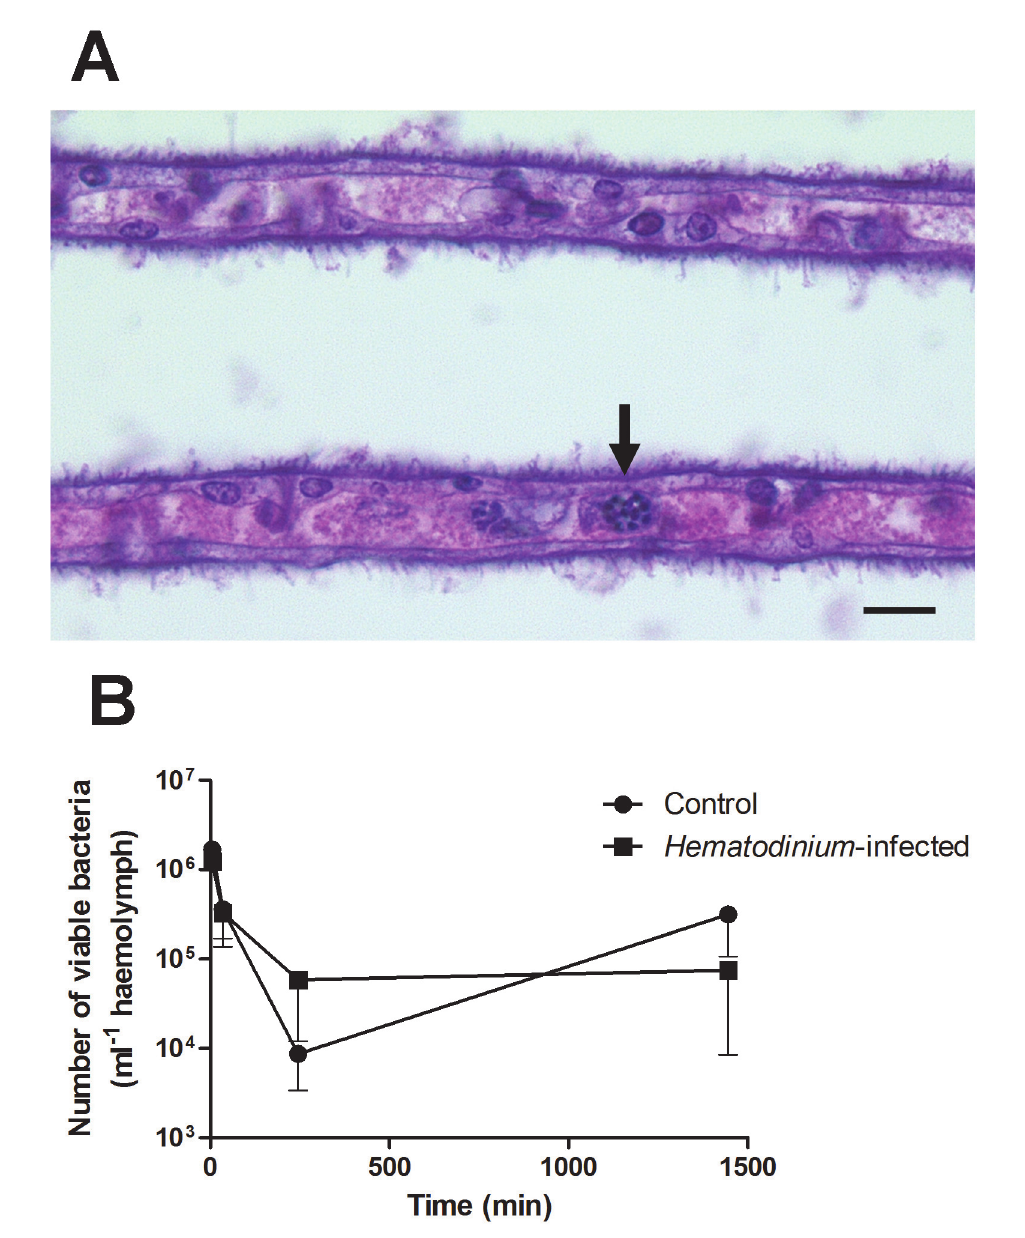
Fig 2. Experimental exploration of the interaction between Hematodinium and its host. (A). Histological appearance of gill lamellae of a crab seven days post-injection of Hematodinium . Note these parasites in the gill space (unlabelled arrow). Scale bar = 10 μ m. (B). Clearance of the gram-positive bacterium, Bacillus subtilis from Hematodinium -infected (early-stage infection) and uninfected juvenile edible crabs ( C . pagurus ). Crabs were injected intrahaemocoelically with 10 5 live bacteria and the numbers of remaining viable bacteria (cfu) in the circulation determined by standard plate counting on tryptone soya agar + 2% NaCl plates. Values shown are means of cfu with standard error of the mean (SEM), n = 5. The values are not statistically different between animals of differing disease status.